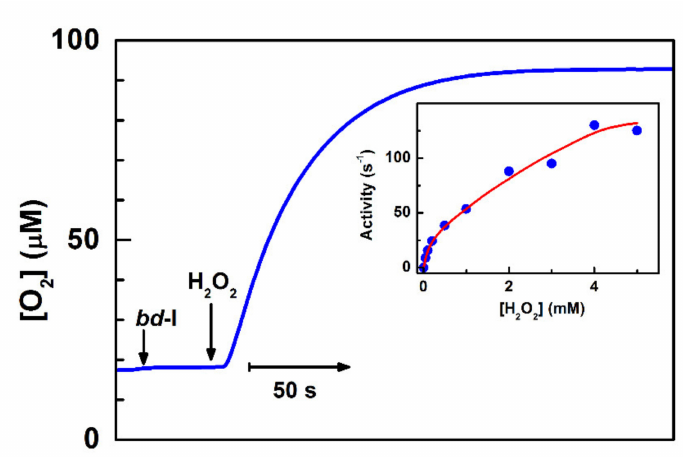
Figure 2. Catalase-like activity of the isolated as-prepared cytochrome bd -I from Escherichia coli ( E. coli ). Main panel: O 2 formation induced by addition of 0.1 mM H 2 O 2 to the oxidase. Inset: Dependence of the rate of O 2 formation on H 2 O 2 concentration. Adapted from [102].